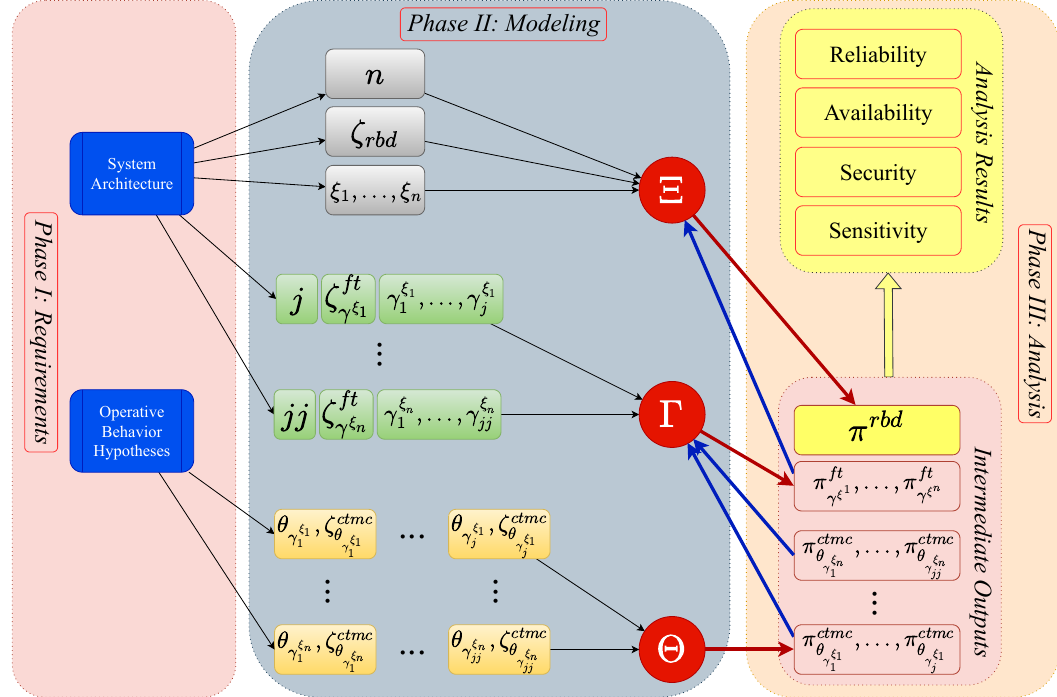
Figure 2. Modeling and analysis framework for security and availability quantification of IoT